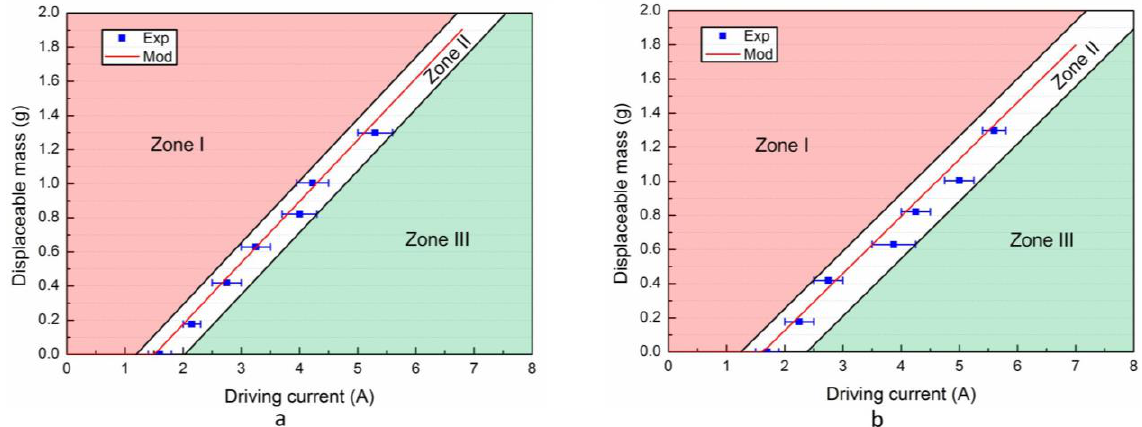
Figure 7. Comparisons between experimental (Exp) and modeled (Mod) displaceable mass for different driving current values: ( a ) displacement along x -axis switching, and ( b ) displacement along y -axis